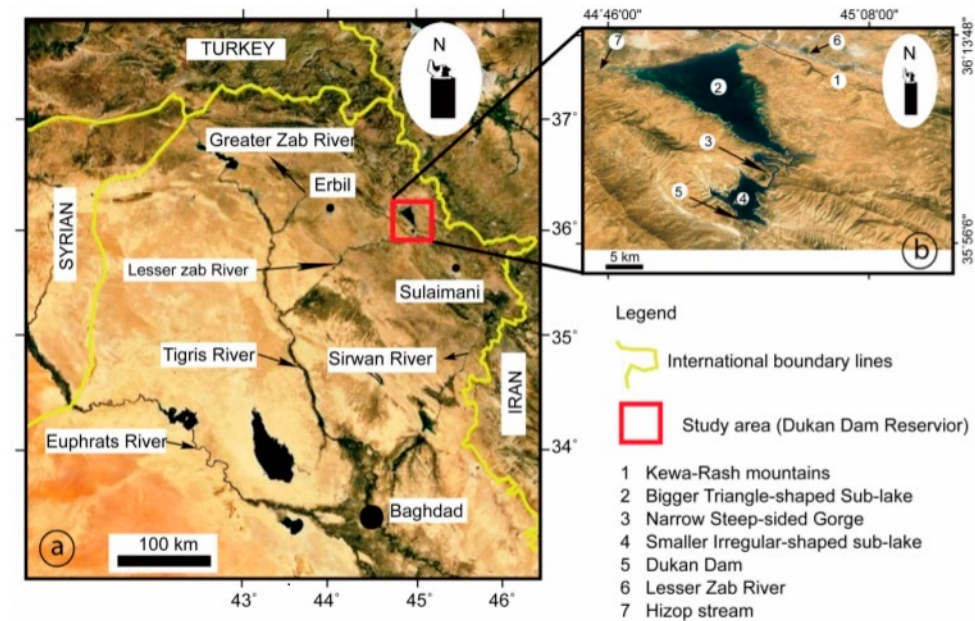
Figure 1. Location map of the Dukan Dam Reservoir. ( a ) Iraq map shows the main rivers in Iraq the location of the Dukan Dam Reservoir. ( b ) A photo taken from Google Earth showing the geographic location, the main rivers feeding the reservoir and its division into two sub-reservoirs (adapted from [43]).